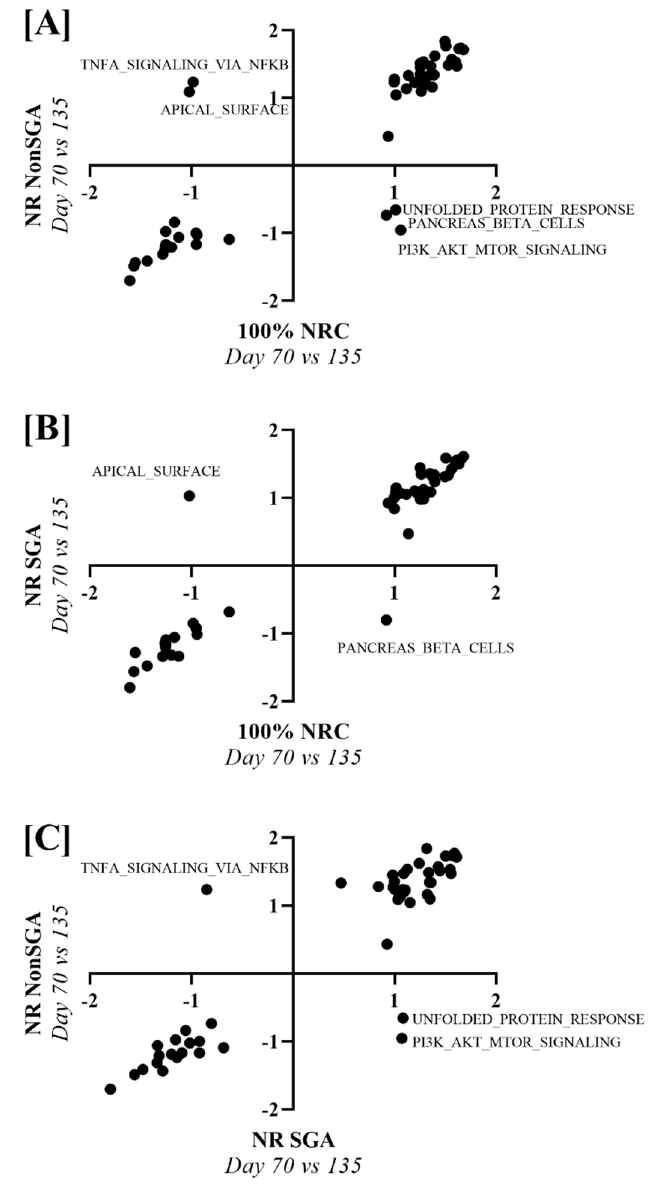
Figure 6. Gene set enrichment analysis of hallmark pathways between treatment groups across days of pregnancy. Nominal enrichment scores (NES) of NR NonSGA (day 70 vs. 135) analyses were plotted against NES values from 100% NRC (day 70 vs. 135) analyses ( A ). NES values of NR SGA (day 70 vs. 135) analyses were plotted against 100% NRC (day 70 vs. 135) analyses NES values ( B ). NES values of NR NonSGA (day 70 vs. 135) analyses were plotted against NR SGA (day 70 vs. 135) analyses NES values ( C ). Points in quadrants with (+, − ) or ( − , +) values were considered differentially regulated, and were labeled with their pathway name.